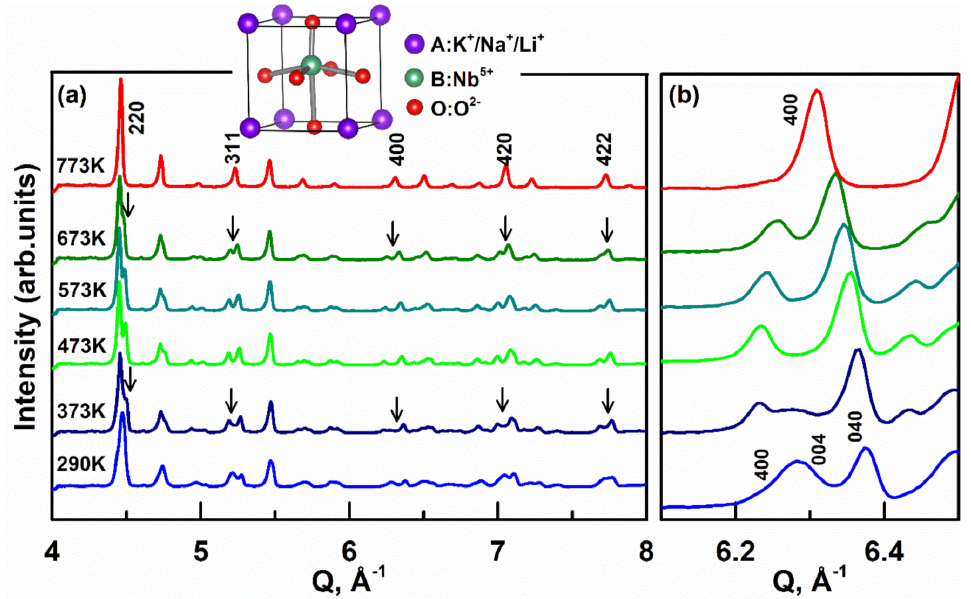
Figure 1. ( a ) Evolution of the neutron diffraction patterns of 0.06LiNbO 3 -0.94K 0.5 Na 0.5 NbO 3 (KNNL6) as a function of temperature from 290 to 773 K. hkl reflections are indexed based on a cubic perovskite structure. Inset is a perovskite structure of KNNL6. The arrows mark changes in hkl peak profiles, which indicate phase transitions. ( b ) Neutron diffraction patterns of {400} reflections as a function of temperature. The x -axis refers to the wavevector